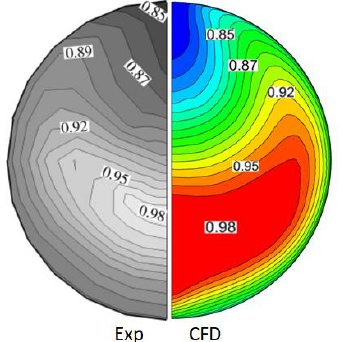
Figure 10. Total pressure distribution at the outlet of the inlet.